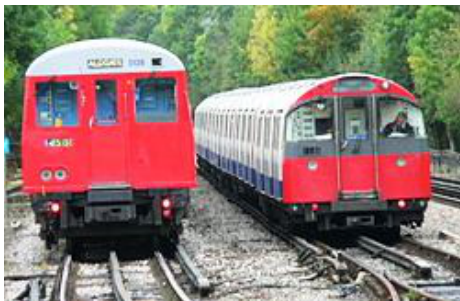
Figure 2. Cars for subsurface and deep-seated Lon- don Underground lines [3]